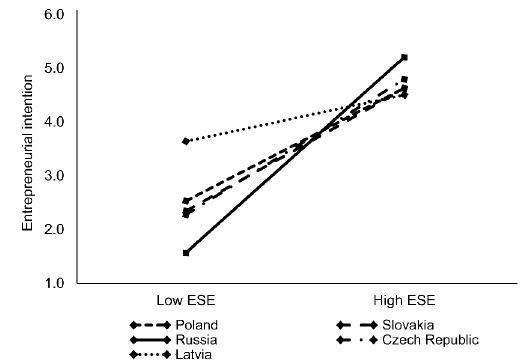
Figure 1. Two-way interaction relationship between ESE and student’s country of residence on entrepreneurial